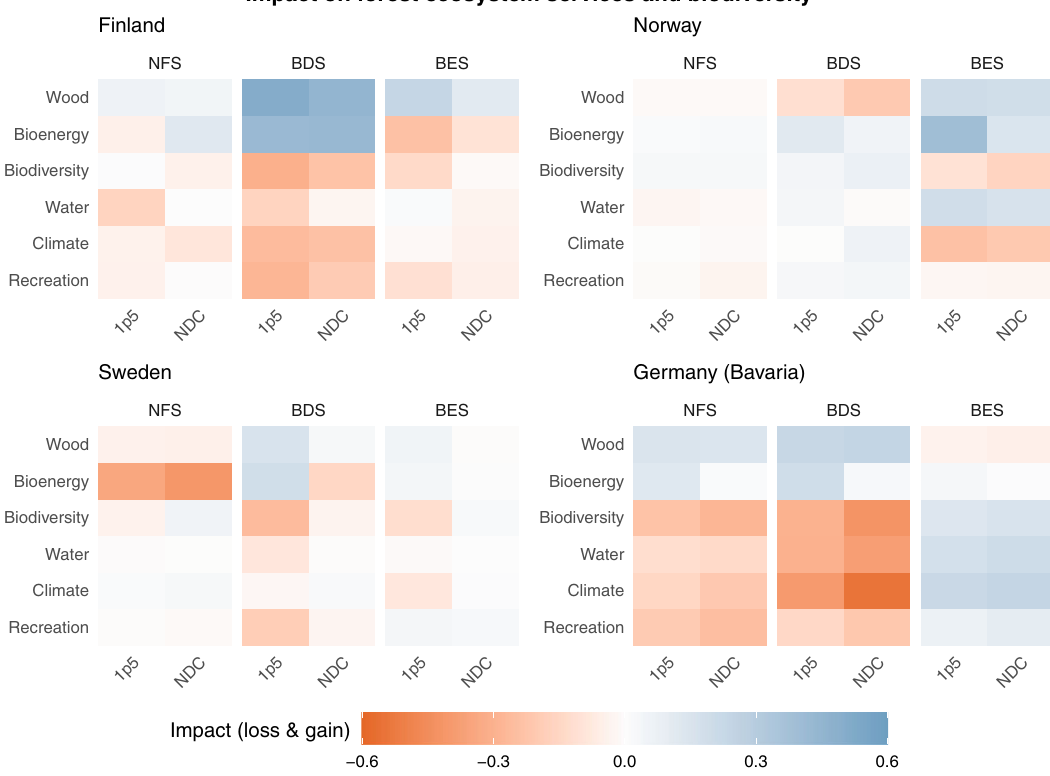
Fig. 5 Impact on the provided forest ecosystem services and biodiversity (FESB) when prioritizing EU climate change mitigation targets. Presented are the differences in normalized indicator values of top-down minus bottom-up, which were further averaged by FESB if a service is represented by more than one indicator. Blue means EU mitigation targets induced a gain in FESB, and red means a loss, NFS stands for national forest strategy, BDS for biodiversity strategy, BES for bioeconomy strategy. The top-down effect on individual indicators used to evaluate FESB are presented in Supplementary Figs. 10 –